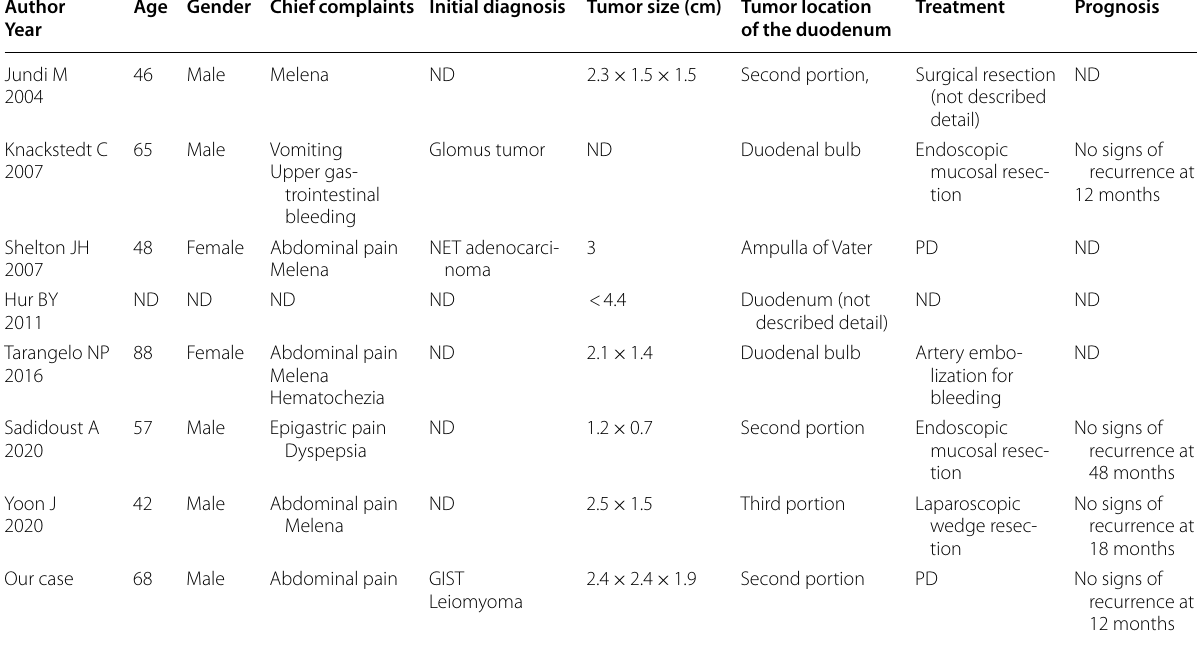
Table 1 Literature review of case reports involving duodenum glomus tumor Author